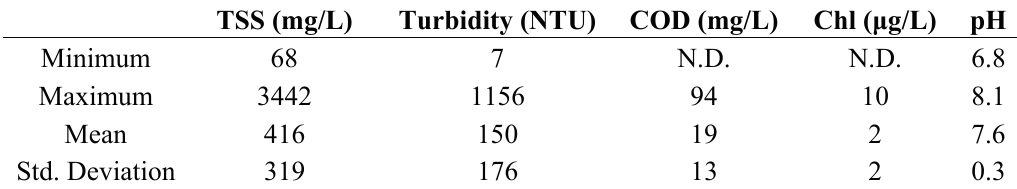
Table 1. Water quality parameters of Wu river